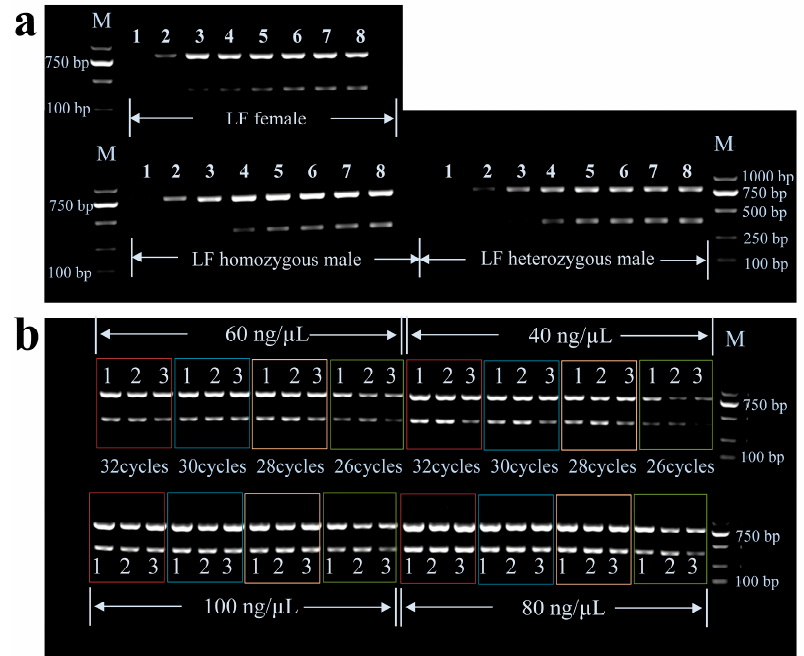
Figure 2. The agarose gel electrophoretic bands of multiplex PCR optimization test. M represent DL2000 DNA Marker. ( a ) The multiplex PCR agarose gel electrophoretic bands of different Ta. 1–8 represent 69.9 °C, 68.7 °C, 67.0 °C, 65.0 °C, 63.3 °C, 62.1 °C, 61.2 °C, 60.6 °C, respectively. ( b ) The multiplex PCR agarose gel electrophoretic bands of different cycle numbers and DNA template concentration; 1, 2, and 3 represent LF homozygous males, LF heterozygous males, and LF fe- males,